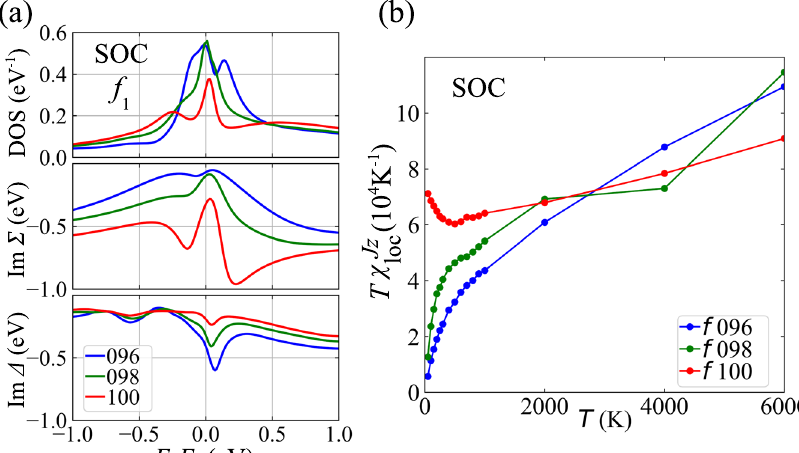
Fig. 6 Kondo effect in smaller structures. a Calculated density of states, the imaginary part of the self-energy and hybridization function of f 1 in SOC system at 300 K. The structures are denoted by 100, 098, and 096 for 0, 2 and 4 percent reduced experimental lattice constants, respectively. b T χ J Z for U-5 f with inclusion of SOC. loc